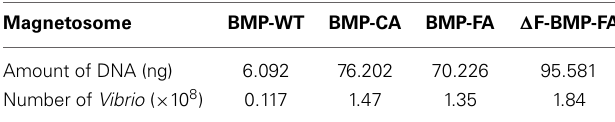
Table 4 | Amount of DNA in Vibrio captured by magnetosome-Ab